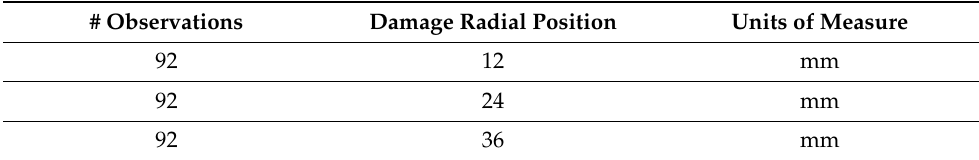
Table 6. Training-set composition for damage